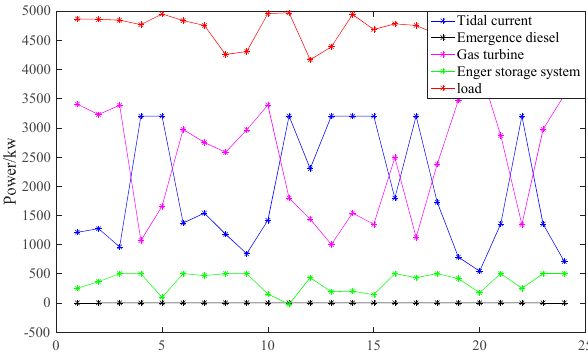
Figure 13. Power output curve of units in grid-connected operation mode.